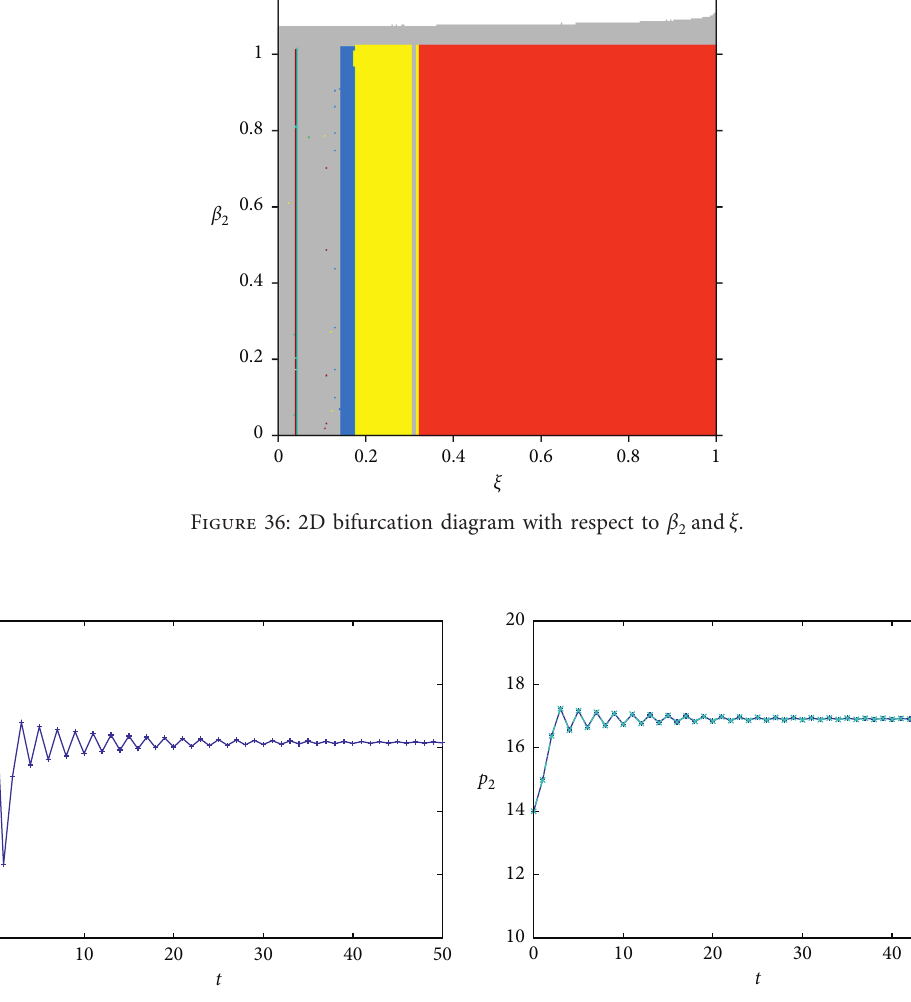
Figure 37: Initial value sensitivity of system (32) after being controlled as ξ � 0 . 35. (a) Initial value sensitivity of w . (b) Initial value sensitivity of p 2